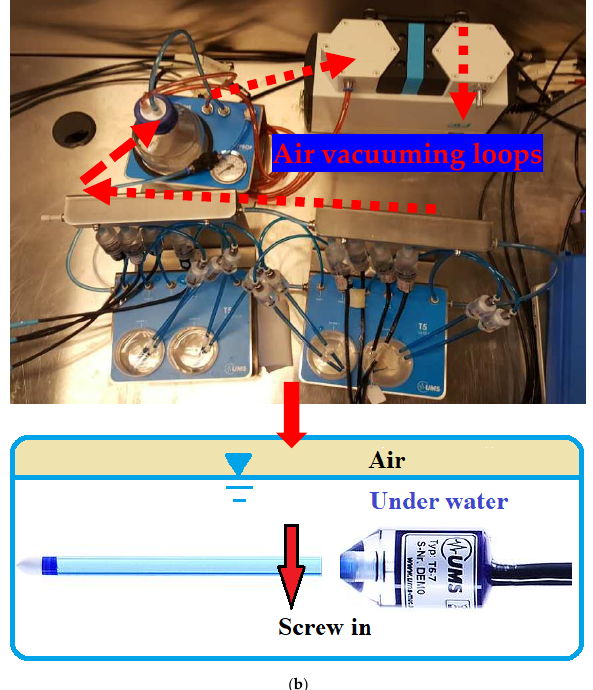
Figure 5. The methods for refilling deaerated water into blue shafts and sensor bodies: ( a ) the manual refilling toolbox-T5 set with a standard operating procedure for T5 refilling and assembly [65] ; ( b ) the automatically refilling kit consisting of a white electrical vacuuming pump connected to a water filtering safety bottle with red pipe, chained to two refilling racks and an innovative assembly [36] . Nevertheless, as each refilling toolbox can only serve each sensor for at least 2.5 h (including 2 h of vacuuming, extra 30 min for refilling and connection operations), it will totally cost several days to fill up 20 – 30 sensors if and only if none of each manual refilling operation fails. Additionally, during such prolonged refilling work, long term sensor stor- age issues will potentially undermine the reliability of utilization. Therefore, there is an urgent need for automatic refilling devices to refill sensors massively and simultaneously by mechanical vacuuming than the manual one. Moreover, with such a mechanical pump running for over 48 h, it is possible to generate more reliable bubbly free water for refilling sensors. With this motivation, the automatically refilling kit was newly developed by UMS [65]. As shown in Figure 5b, all shafts and sensor bodies should be detached from each other and mounted to the refilling racks. Two refilling racks enable automatically refilling